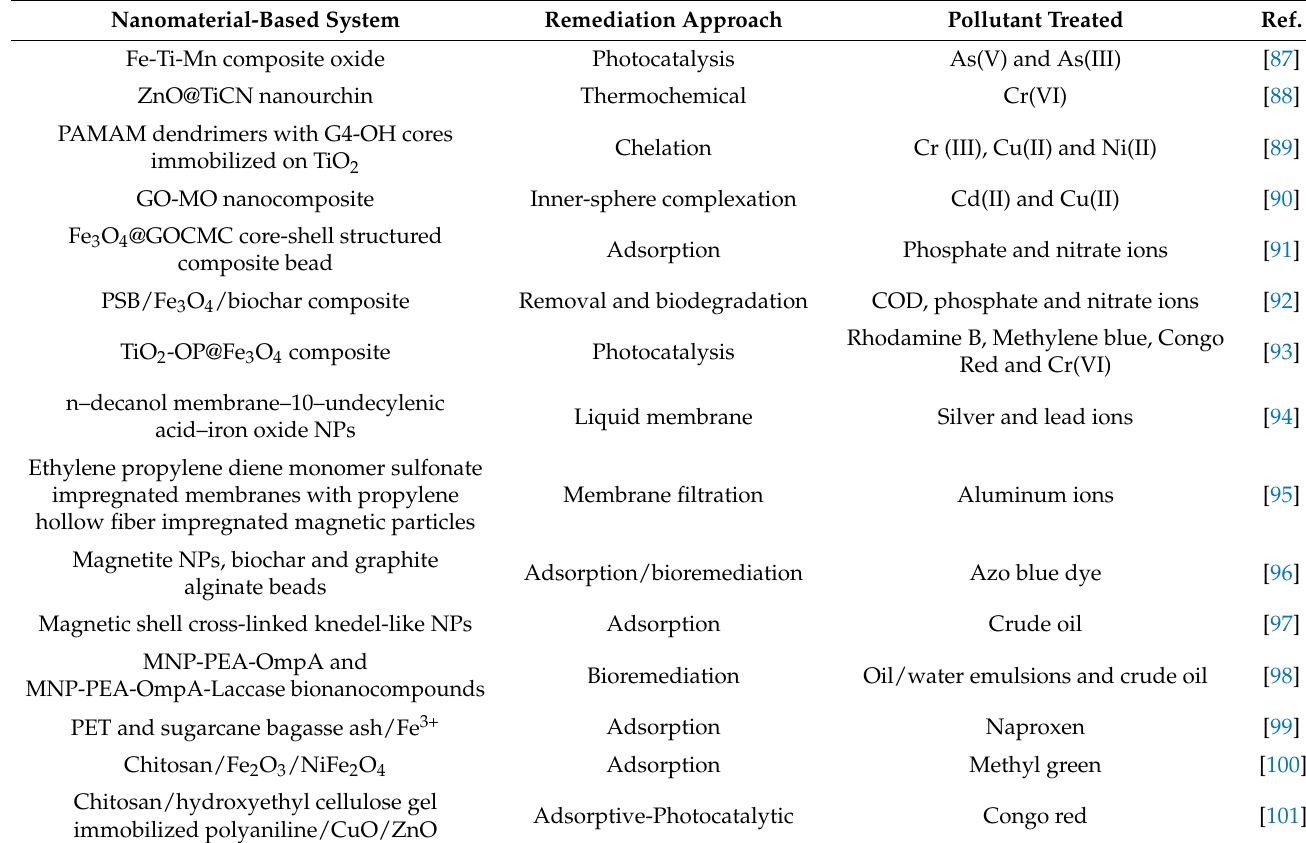
Table 3. Some MONP-based systems for remediation and bioremediation